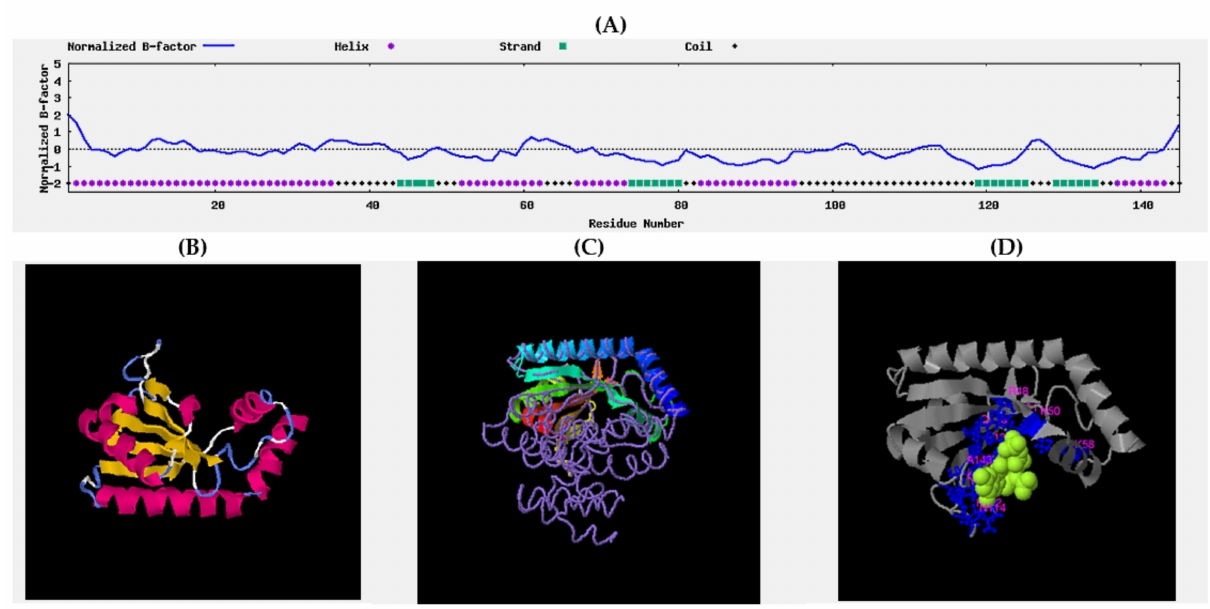
Figure 9. Supporting graphs: ( A ) B-factor plot; ( B ) homology model; ( C ) structure superposition of modeled protein (cartoon) and best hit—1vj7A (coil); ( D ) predicted ligand binding